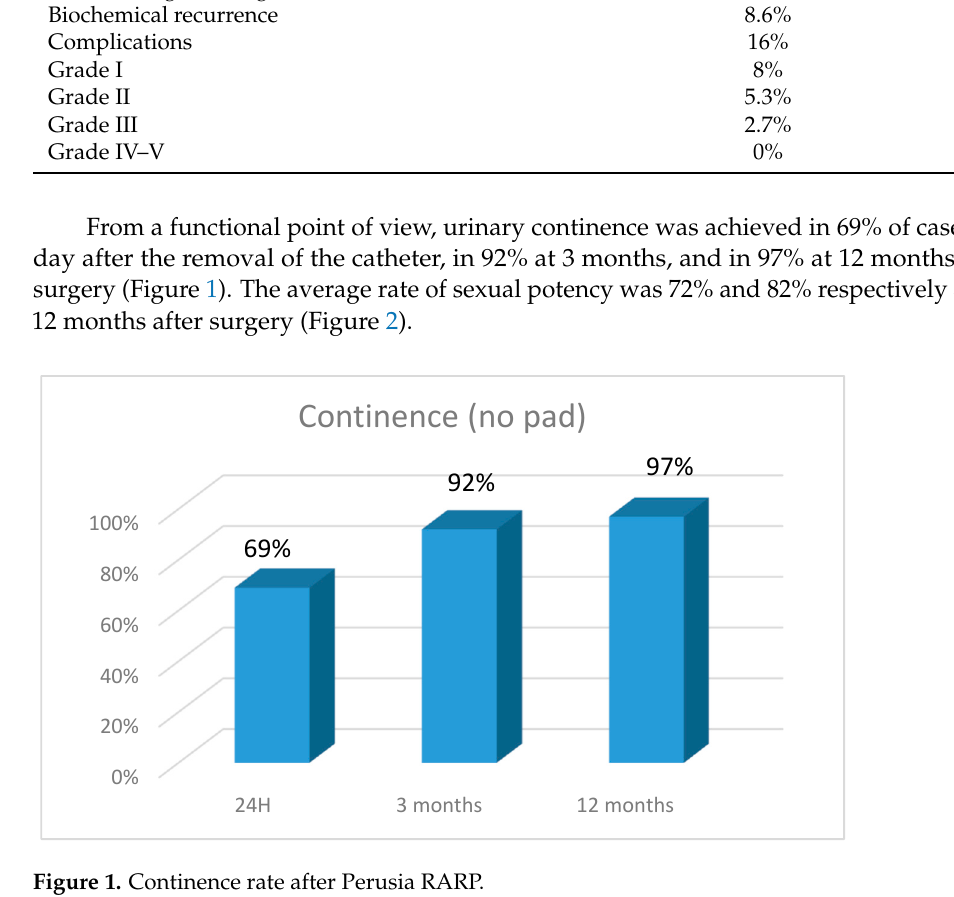
Table 1. Summary of the perioperative results, the rate of positive surgical margins, the rate of Biochemical Recurrence (BCR) and complications; those relating to urinary continence are in Table 2, and those relating to sexual potency are in Table 3.